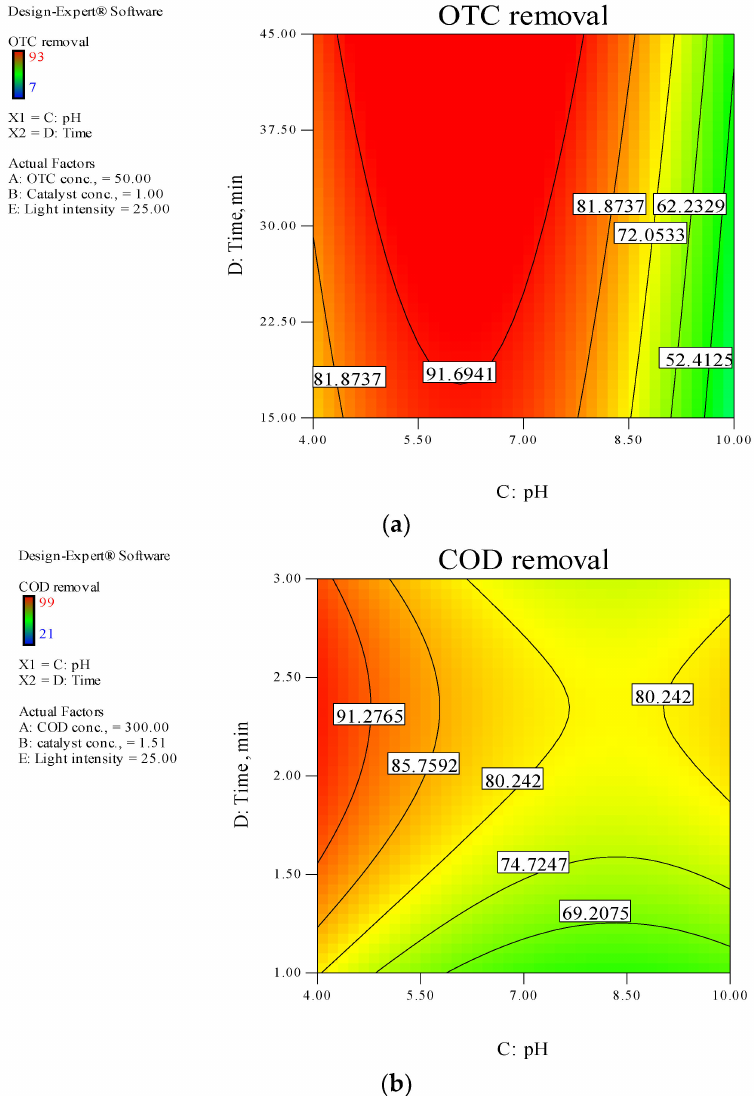
Figure 8. Contour plot of ( a ) OTC and ( b ) COD removal efficiency as a function of pH and irradiation